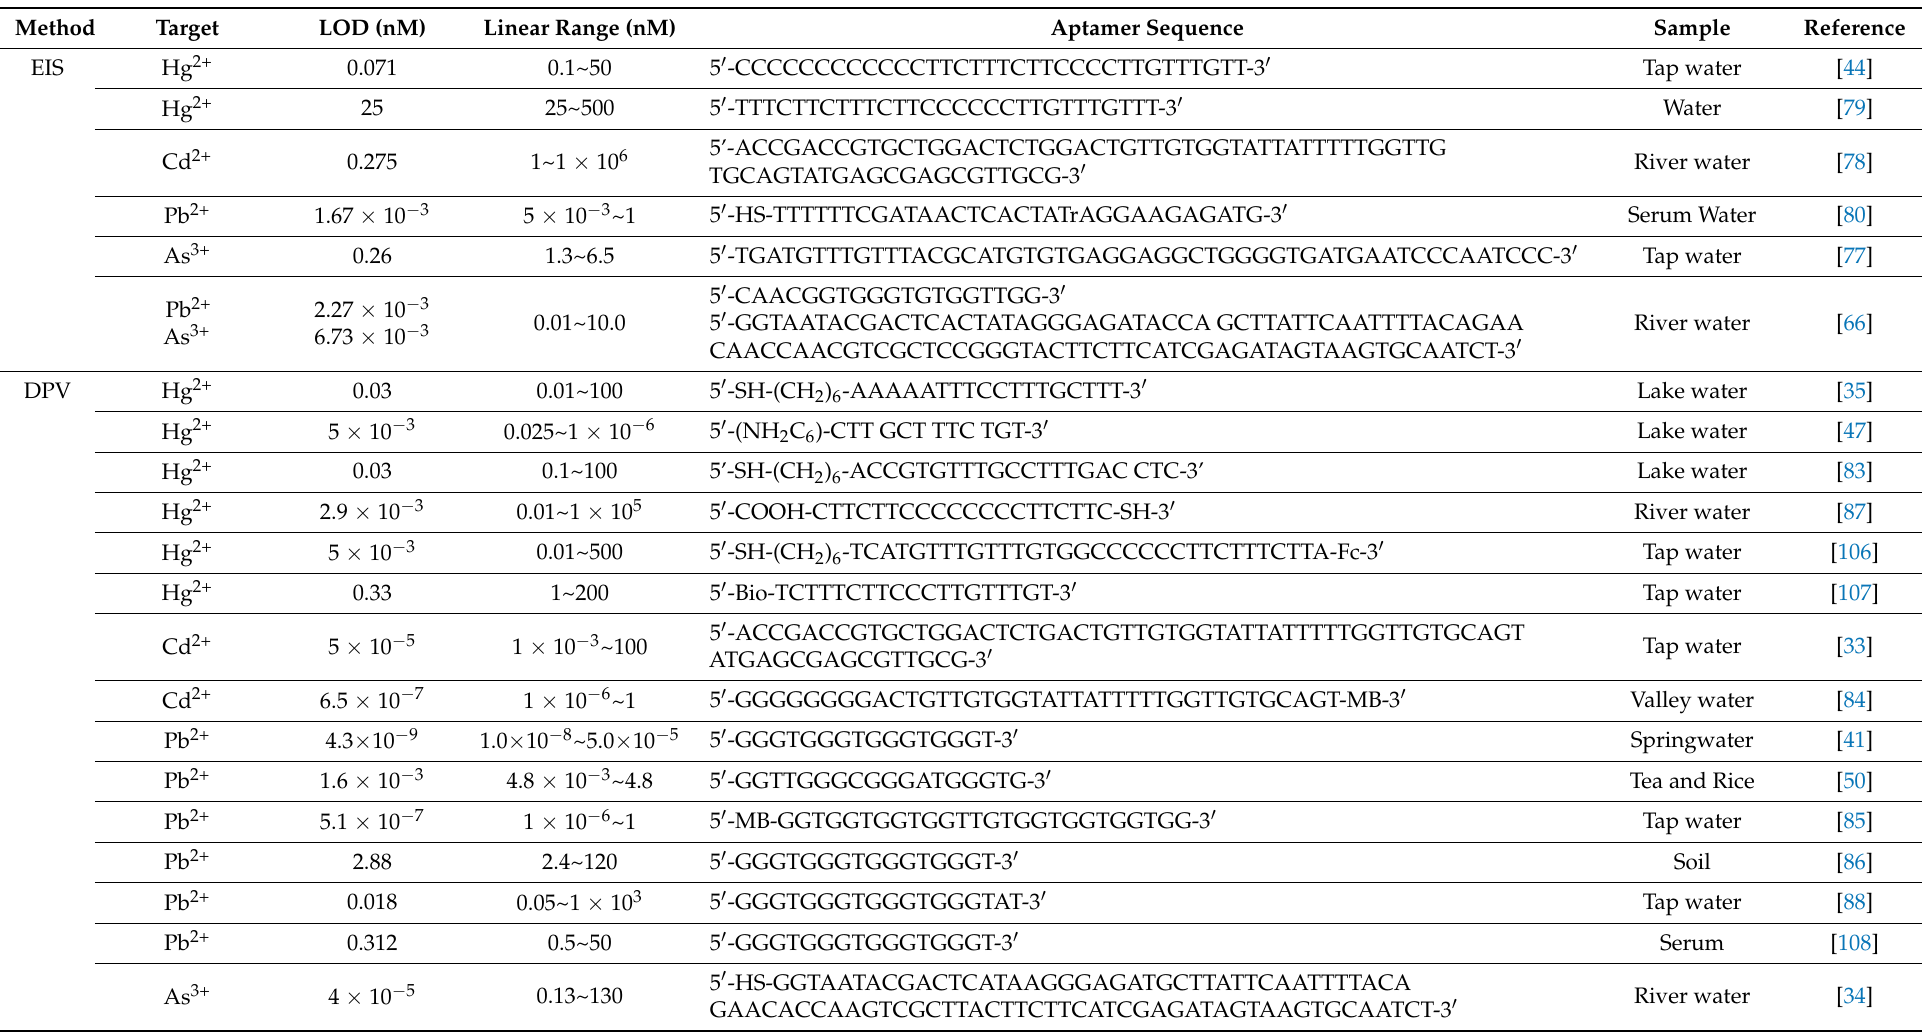
Table 1. Application of the electrochemical sensor in the detection of heavy metal